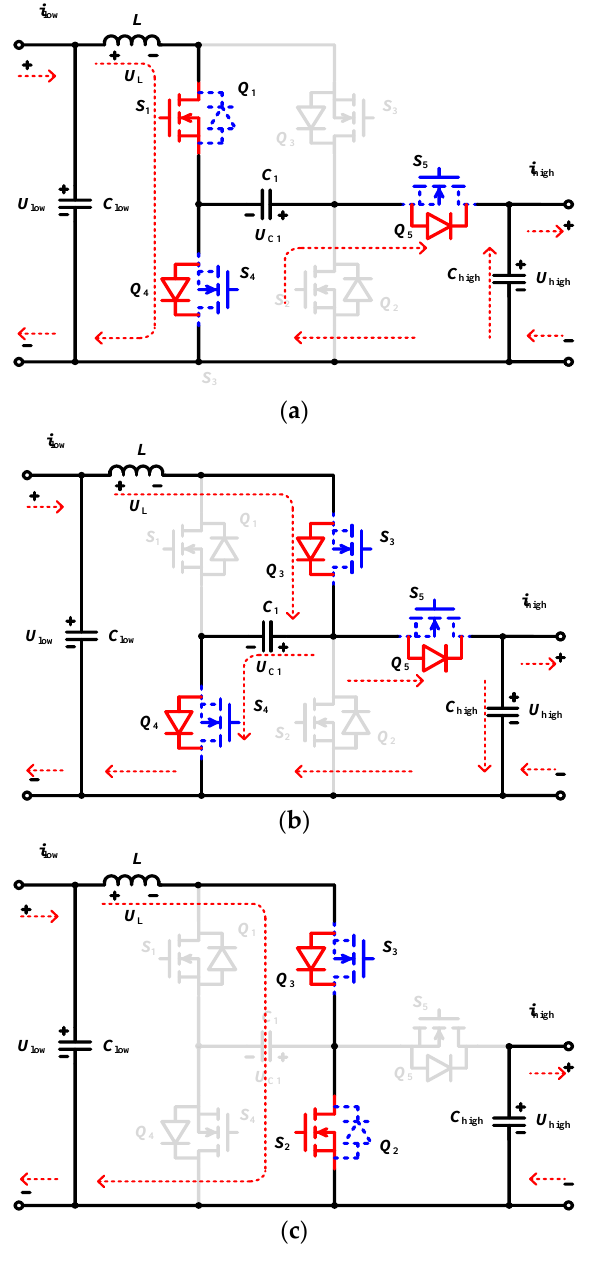
Figure 3. Energy flow paths of the proposed converter in the step-up mode; ( a ) S 1 S 2 = 10; ( b ) S 1 S 2 = 00; ( c ) S 1 S 2 = 01.